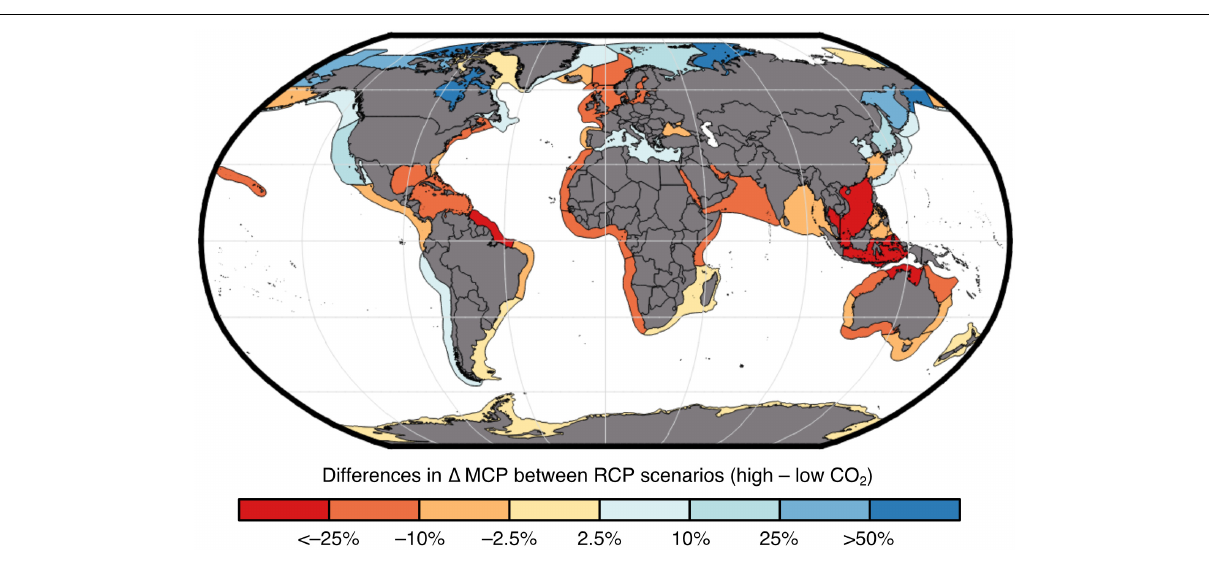
FIGURE 3 | Projected impacts by considering multiple changes in environmental conditions on maximum catch potential (MCP) of marine invertebrates across large marine ecosystems. Results shown are for the 2091–2100 period (relative to 1951–1960) in high CO 2 (RCP 8.5) relative to low CO 2 scenario (RCP